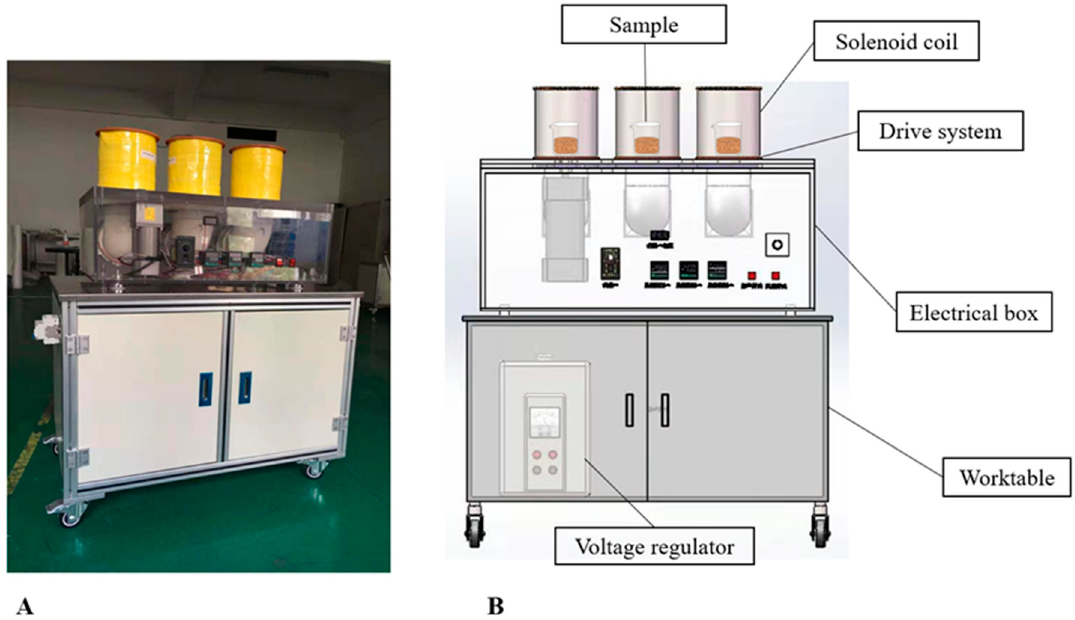
Figure 1. Low intensity rotating magnetic field device. ( A ) The photo of the device; ( B ) the schematic diagram of the device. diagram of the